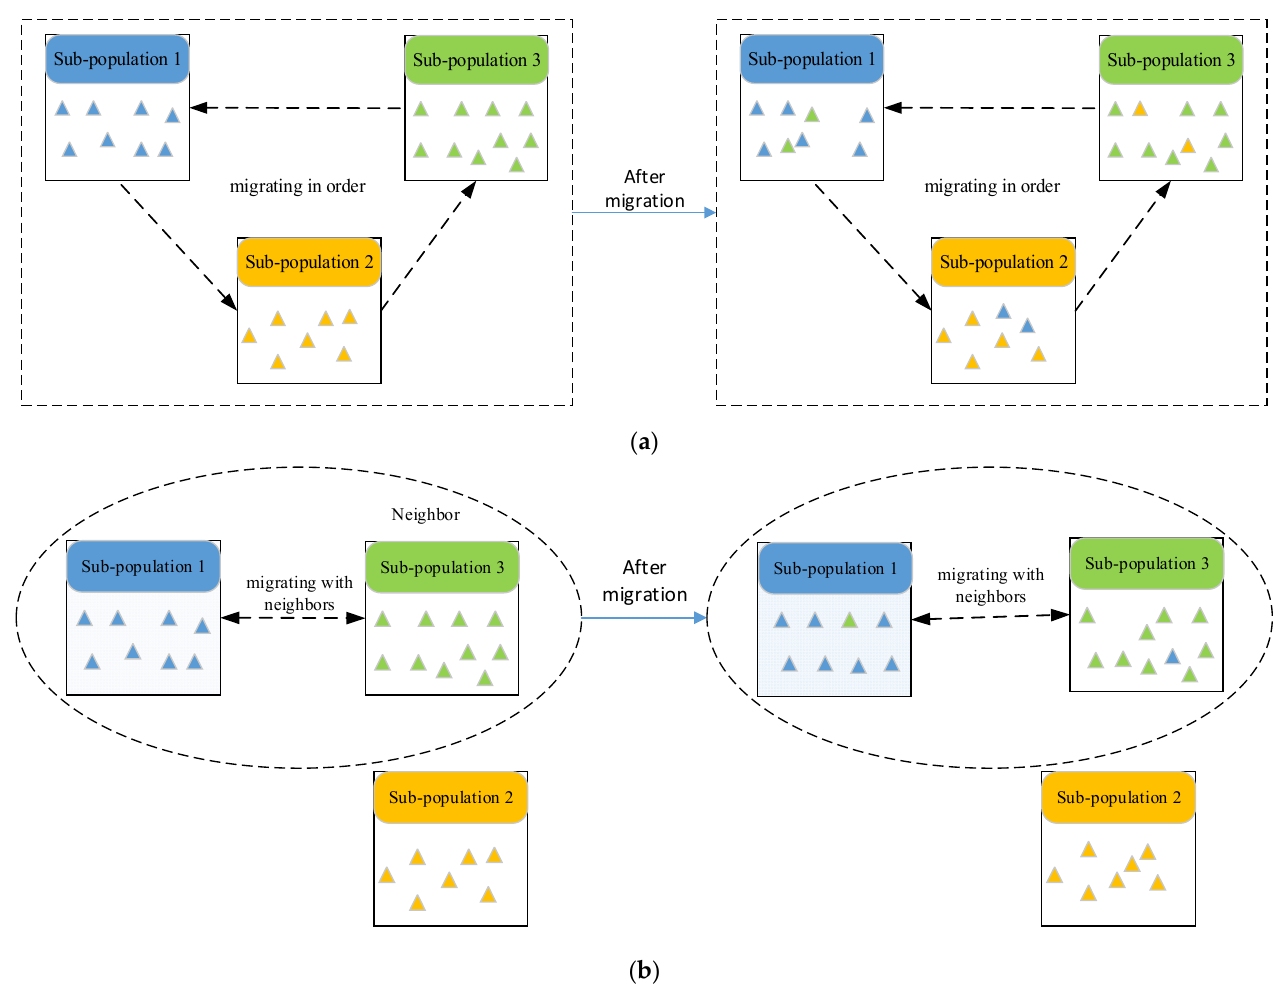
Figure 5. Migration modes: ( a ) circular migration; ( b ) interaction migration.